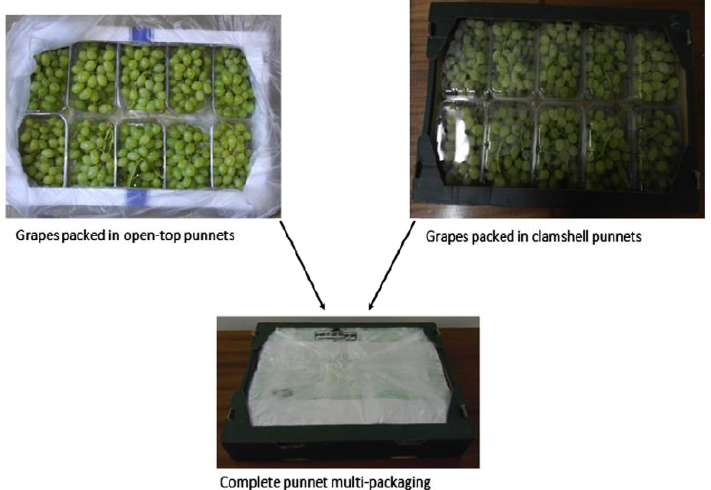
Figure 6. Multilayer of packaging for table grapes [96] .